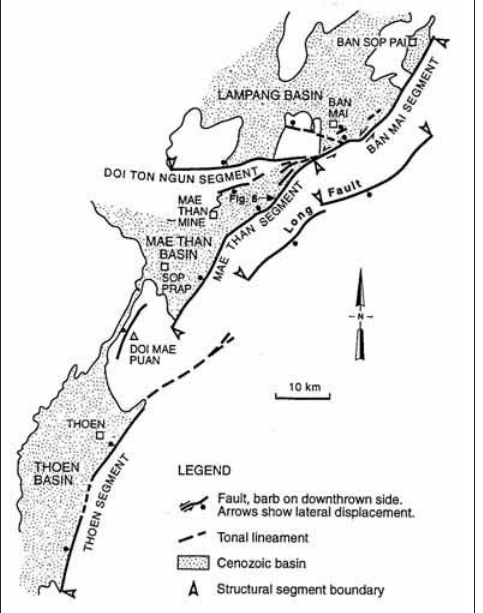
Fig. 5. Simplified map of the Thoen Fault System showing fault segments and localities mentioned in the